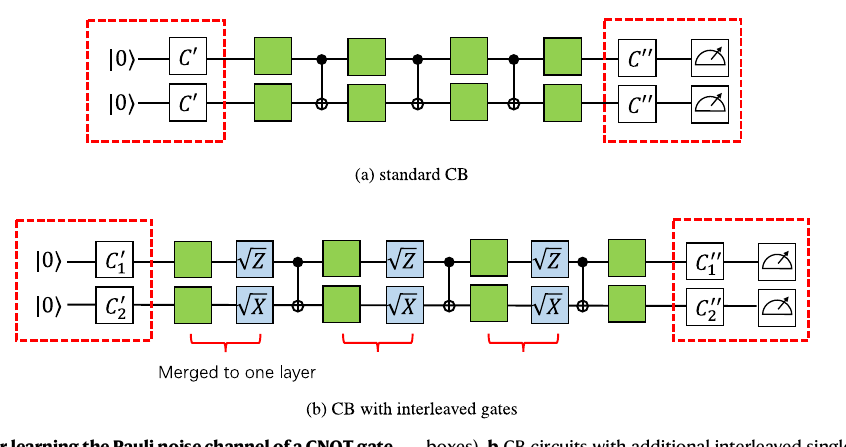
boxes). b CB circuits with additional interleaved single qubit Clifford gates (blue